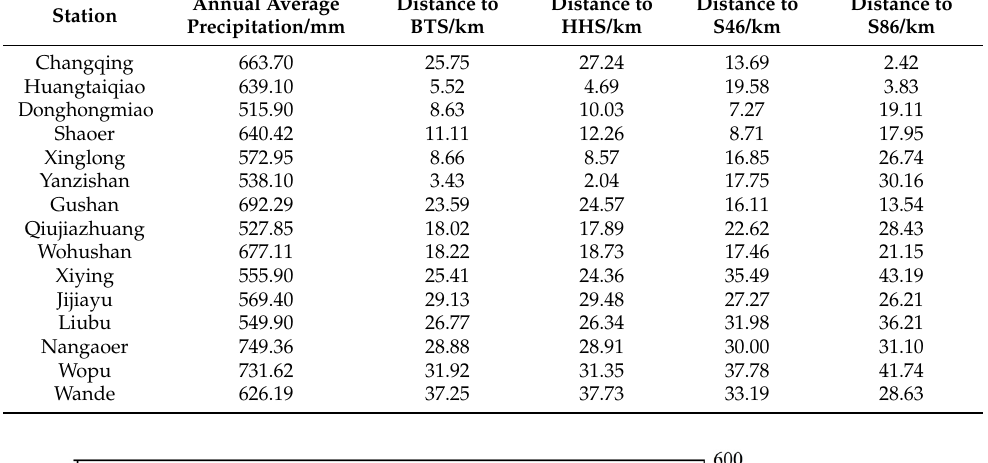
Table 1. Basic information of each precipitation station.